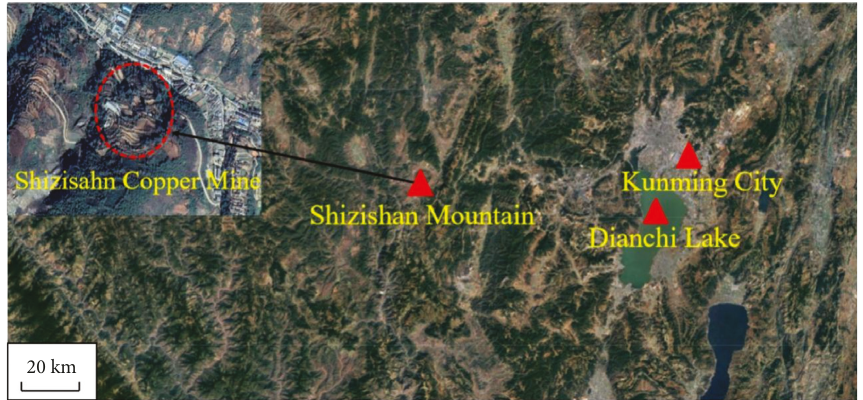
Figure 1: Geographical location and surrounding geological map of Shizishan Copper